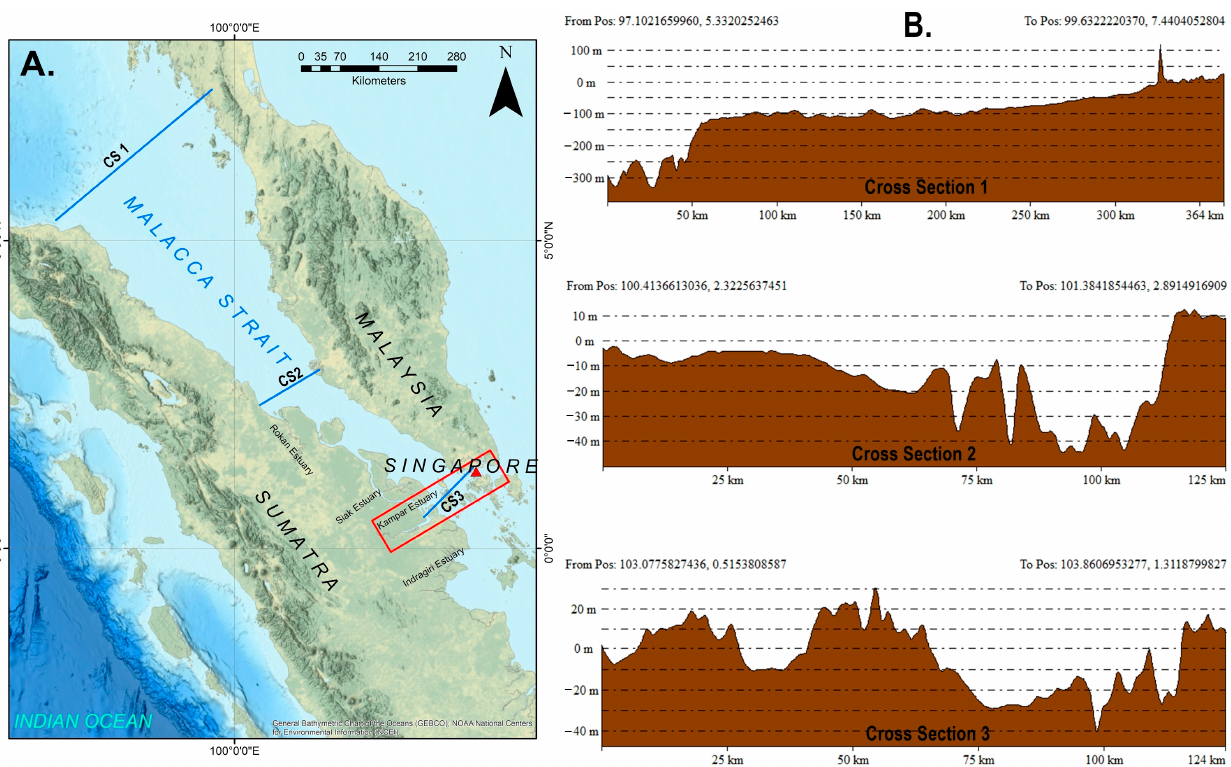
Figure 1. The assessed area is indicated by a red square ( A ) and the cross-section of Malacca Strait’s bottom morphology ( B ). The red triangle denotes the position of the tide gauge measurement and sampled altimetry data.